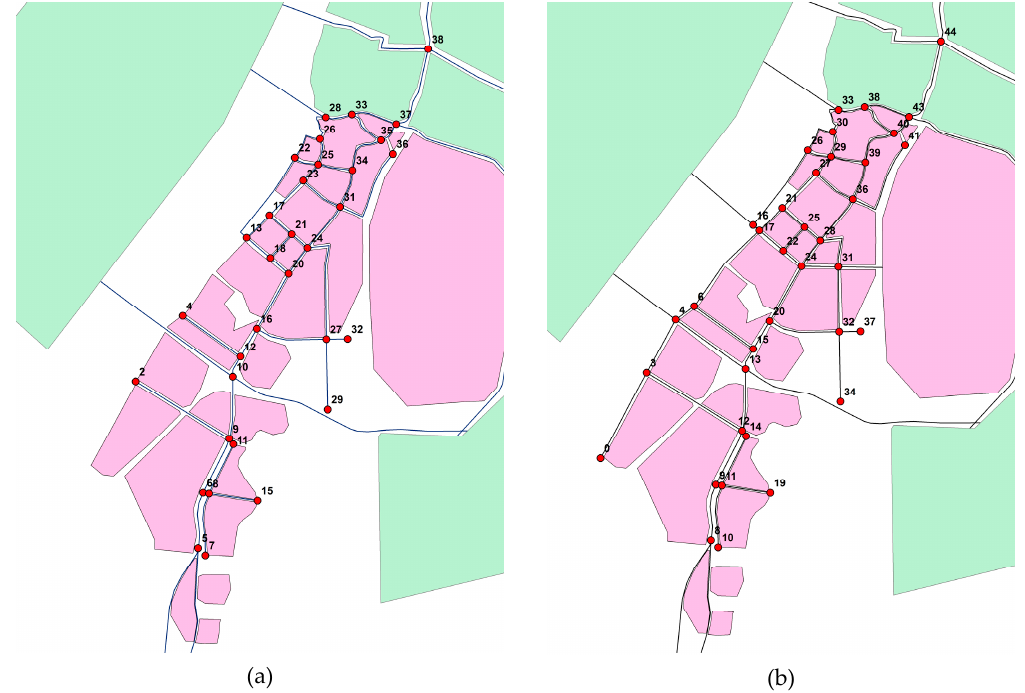
Figure 6. Numbering and distribution of road intersections. ( a ) Numbering and distribution of existing road intersections; ( b ) Numbering and distribution of planned road